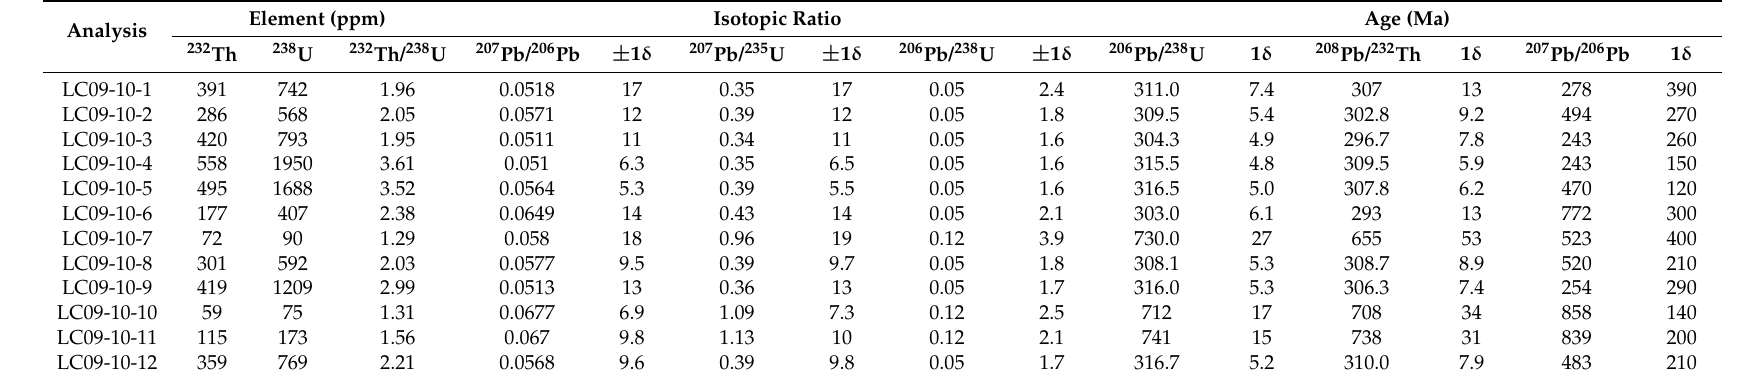
Table 2. SHRIMP zircon U-Pb isotopic data for basaltic tuff of the Laochang.